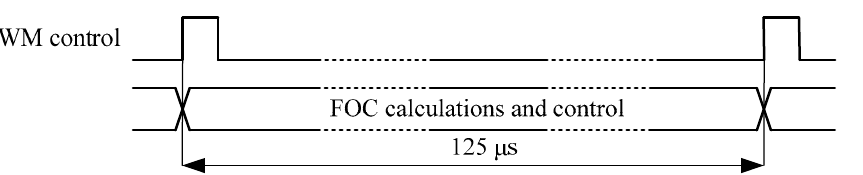
Figure 11. Time dependencies for the pulse width modulation (PWM) module.